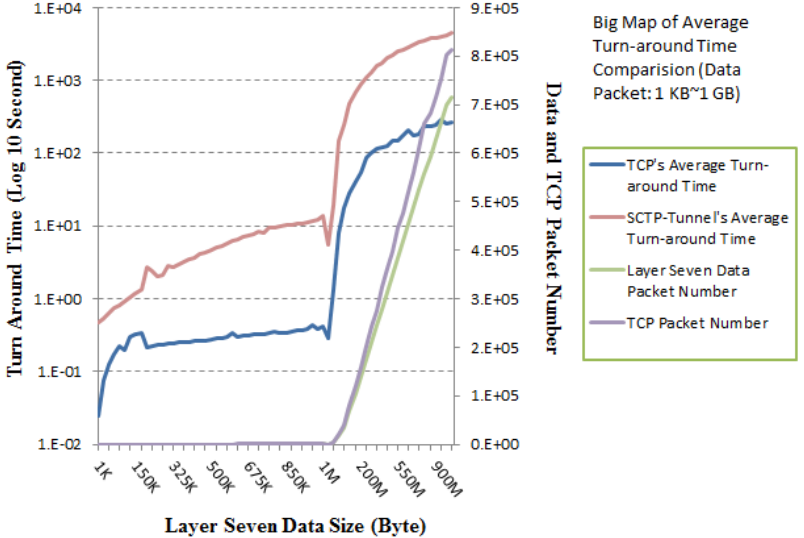
Figure 9. Turn-around time comparison.